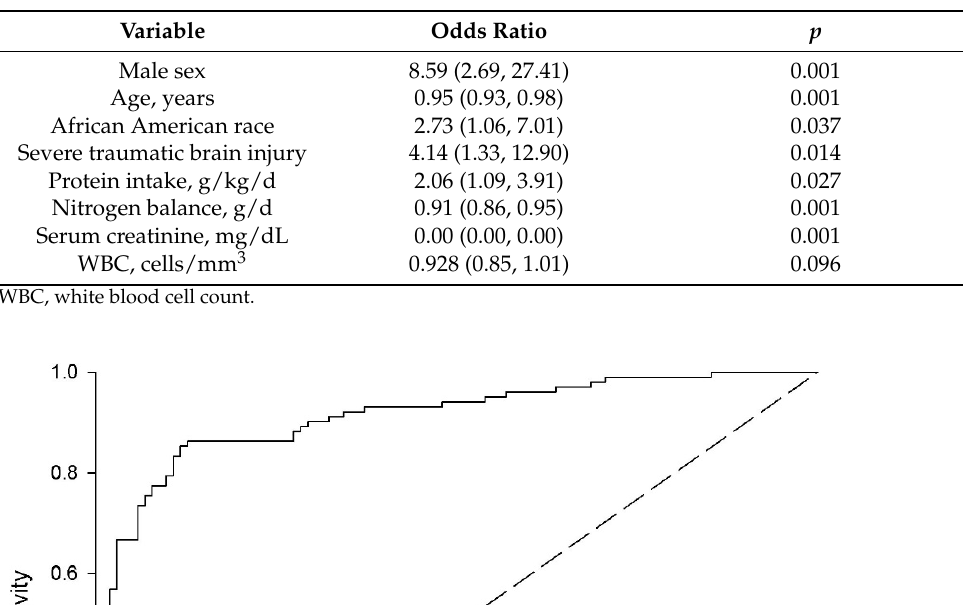
Table 6. Multivariate analysis of variables associated with augmented renal clearance. Data given as the mean (95% confidence interval).